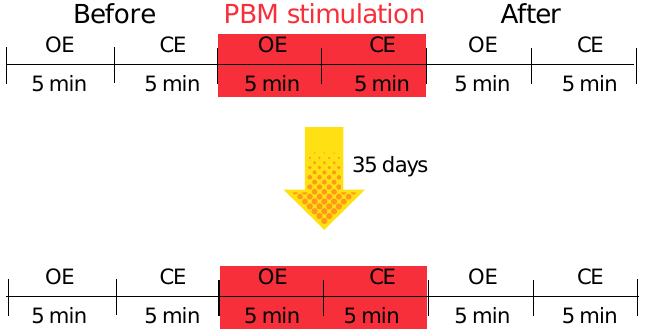
Figure 4. Schematic representation of the study design.